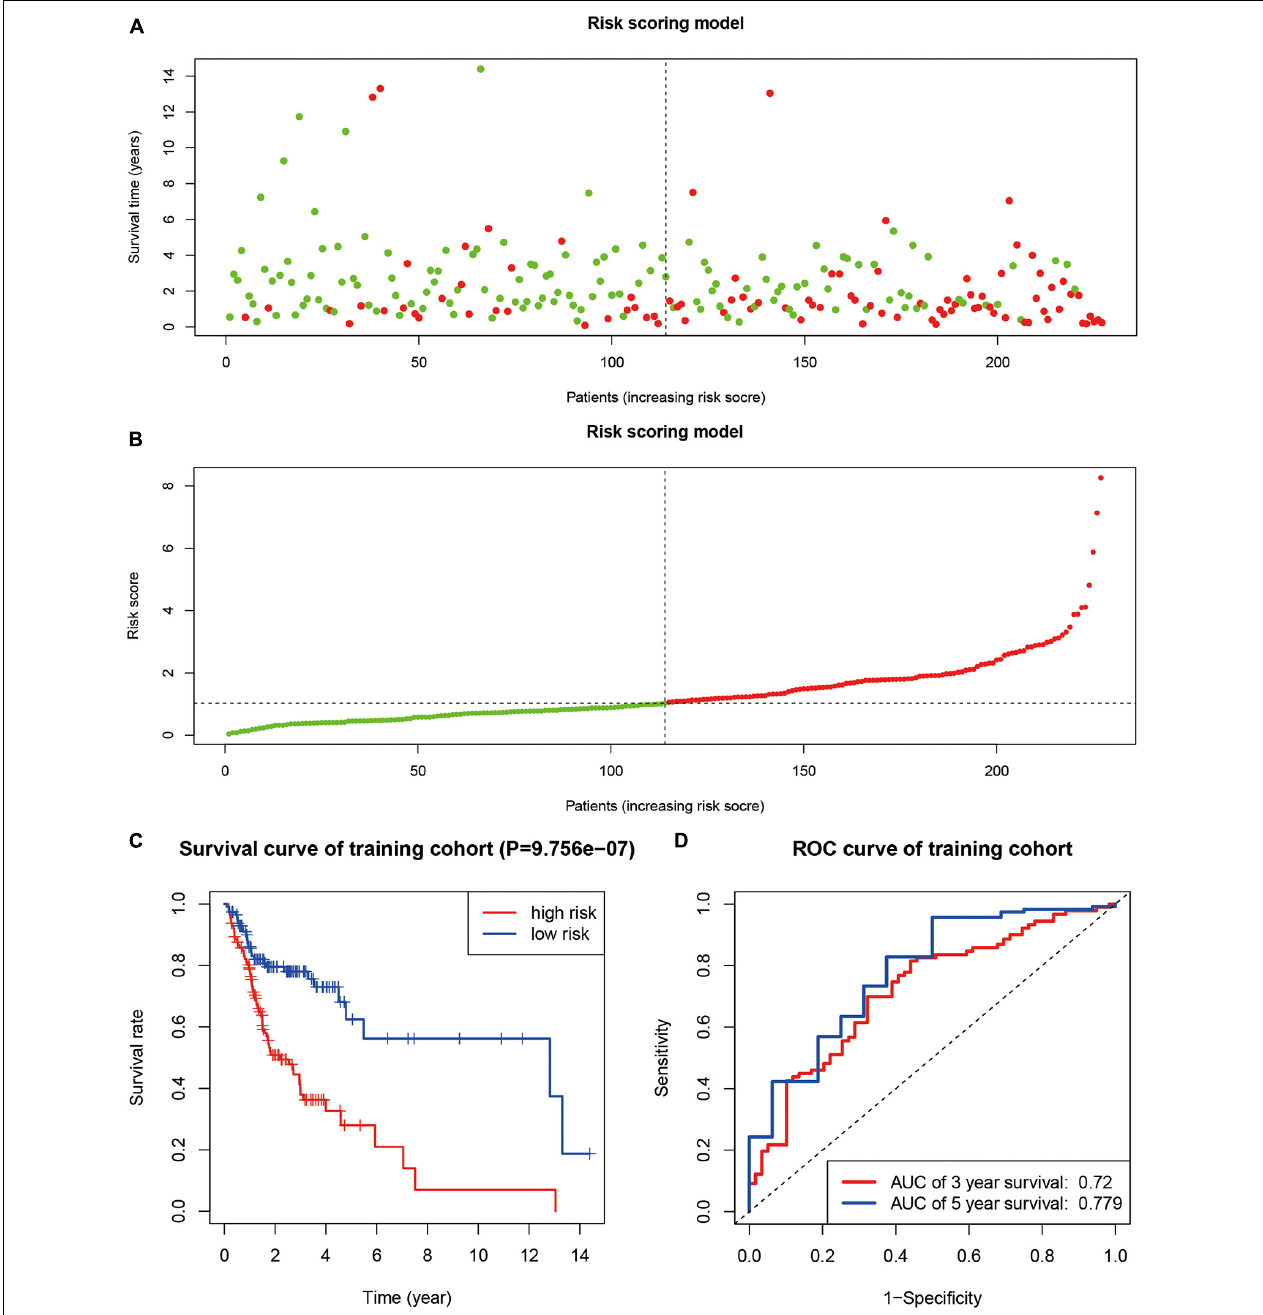
FIGURE 6 | The construction of a prognosis model. (A,B) The survival status and risk score of each sample. (C) Kaplan–Meier curve in TCGA training group. (D) ROC curve in TCGA training group.